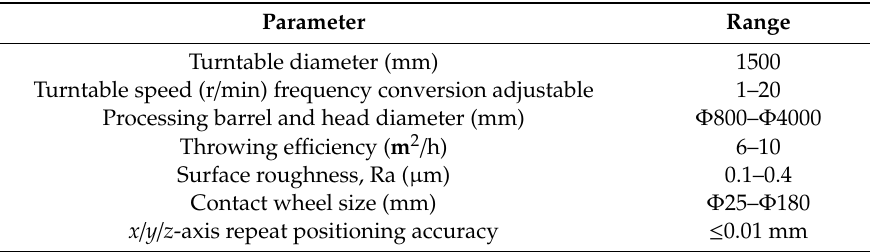
Table 3. Main technical parameters of machine tools.